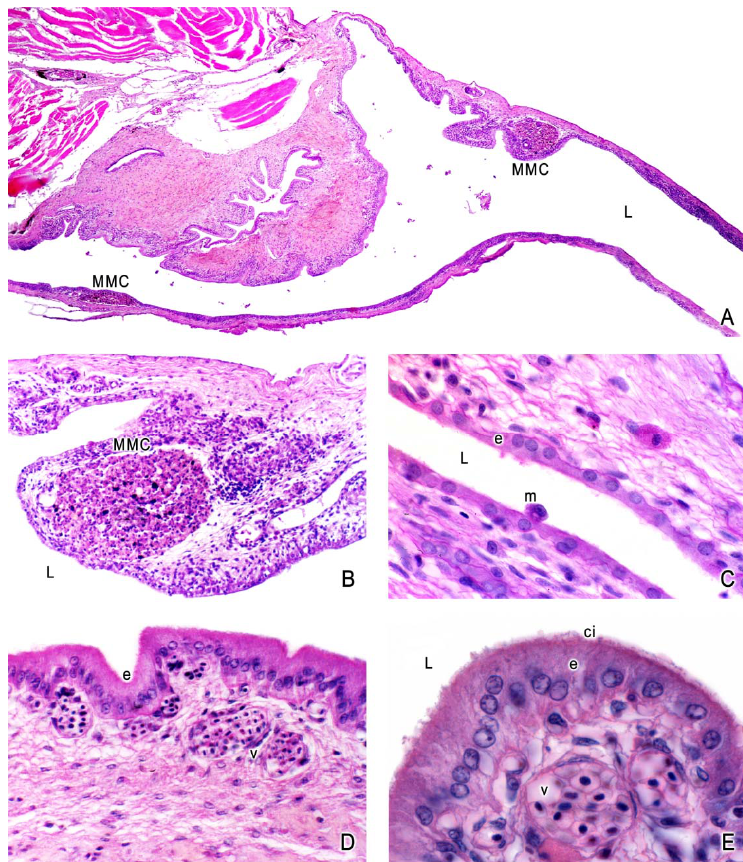
Figure 2. Histological components of the gonoduct. ( A ) The gonoduct of Poecilia reticulata forms the caudal portion of the saccular ovary with a central lumen (L). Melano ‐ macrophage centers (MMC) are adjacent to the luminal epithelium. 32×. ( B ) Melano ‐ macrophage center (MMC) surrounded by connective tissue.78×. ( C ) The luminal epithelium (e) is formed by cubic cells. A macrophage (m) is seen in the lumen (L). 200×. ( D,E ) Epithelium formed by columnar cells (e) with cilia (ci) bordering the lumen (L). The connective tissue contains abundant blood vessels (v). 500×, 800×.